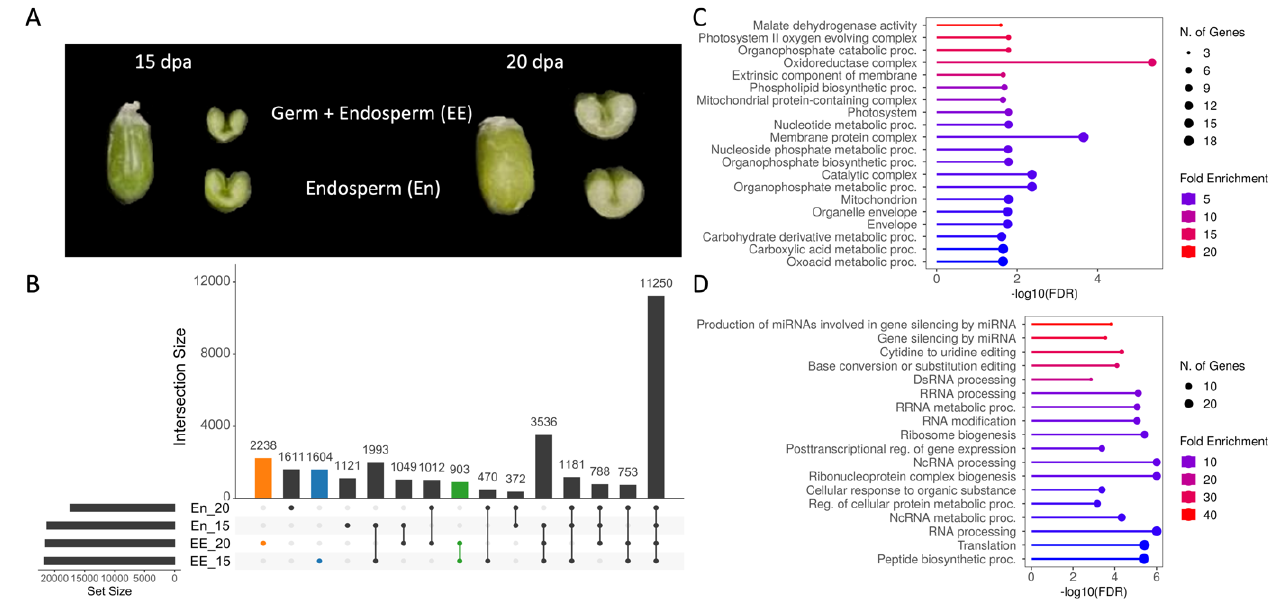
Figure 4. The identification of genes with expression in germ and endosperm parts of a seed. ( A ) The view of whole and dissected seeds at 15 and 20 dpa used for RNA isolation and ONT sequencing. ( B ) Upset plot showing intersection of genes expressed in four samples. The intersections for the genes expressed in EE_15, EE_20 and in both samples are highlighted. ( C , D ) GO enrichment analyses of genes expressed in EE_15 and EE_20, respectively.